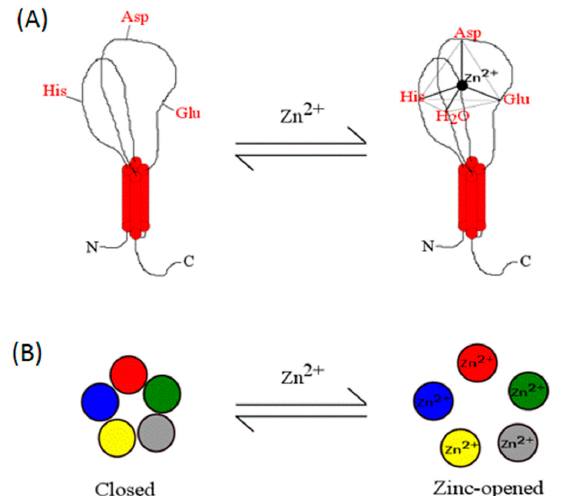
Figure 6. Hypothetical model of a zinc-gated receptor channel, ZAC, and its putative coordination sphere. ZAC is a member of the pentamer superfamily of ionic receptor channels; its subunit composition is likely homomeric, composed of five identical subunits with four transmembrane domains each. ( A ) Graphic of a single subunit showing putative residues involved in the zinc coordination shell. In the presence of the metal, the putative receptor coordination site binds zinc probably with tetrahedral geometry; ( B ) The circle represents the five receptor subunits which constitute the active channel; in the presence of the metal, the channel opens and elicits an excitatory inward current. Based on the proposed model, since the metal coordination sphere is intrasubunit, five zinc atoms are required to open the channel.